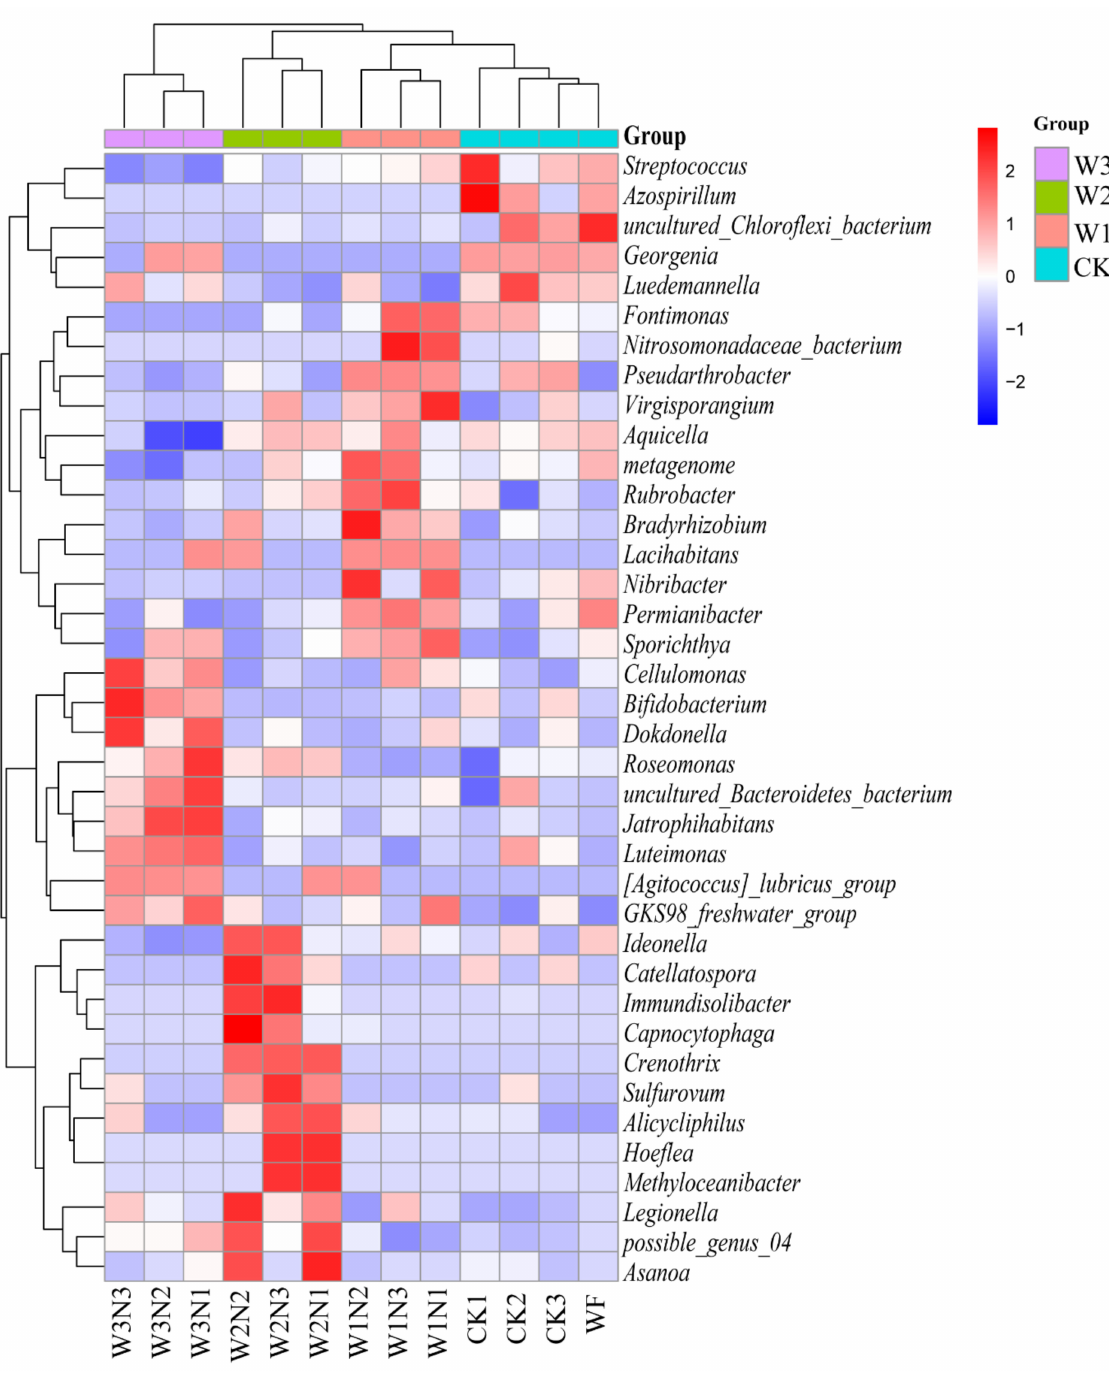
Figure 5. Thermal map of differential species abundance of bacteria. Note: The above picture shows the heat map at the genus level; the horizontal axis indicates the sample information, and the vertical axis is the species annotation. On the left side of the figure is the species clustering tree and the clustering branch group above indicates that the samples come from different groups. The red and blue tiles indicate higher and lower relative abundance,